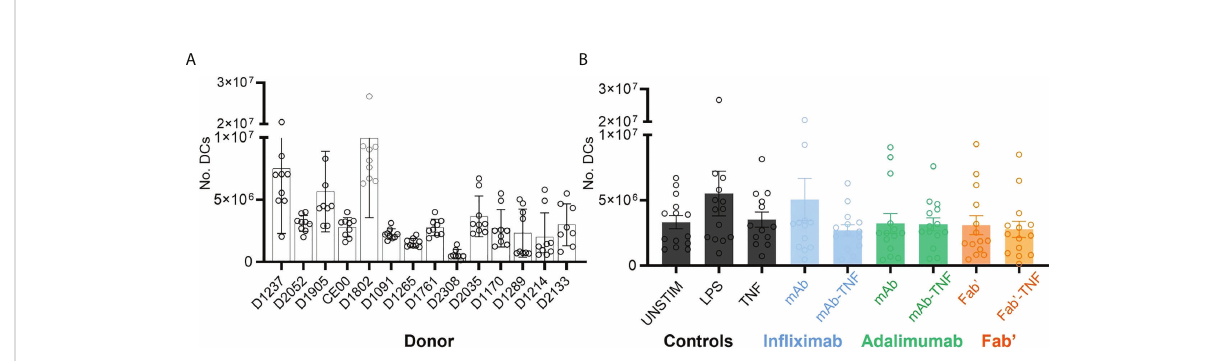
FIGURE 3 Dendritic cell yields after monocytic puri fi cation from PBMCs, LPS stimulation and treatment with TNF, antagonists or immune complexes. (A) Total yield of DCs derived from fourteen independent sets of puri fi ed CD14+ monocytes. Bars represent the mean and SEM per donor (n=9), where each circle corresponds to one of the nine treatment conditions: UNSTIM, LPS, TNF, INF, ADAL, Fab ’ , INFL-TNF, ADAL-TNF and Fab ’ -TNF. (B) Yield of DCs plotted by treatment condition: TNF antagonist-free controls (black), INFL and INFL-TNF (blue), ADAL and ADAL-TNF (green) and Fab ’ and Fab ’ -TNF (orange). Each bar represents the mean and SEM per fourteen independently stimulated DCs, where each circle corresponds to the number of cells per